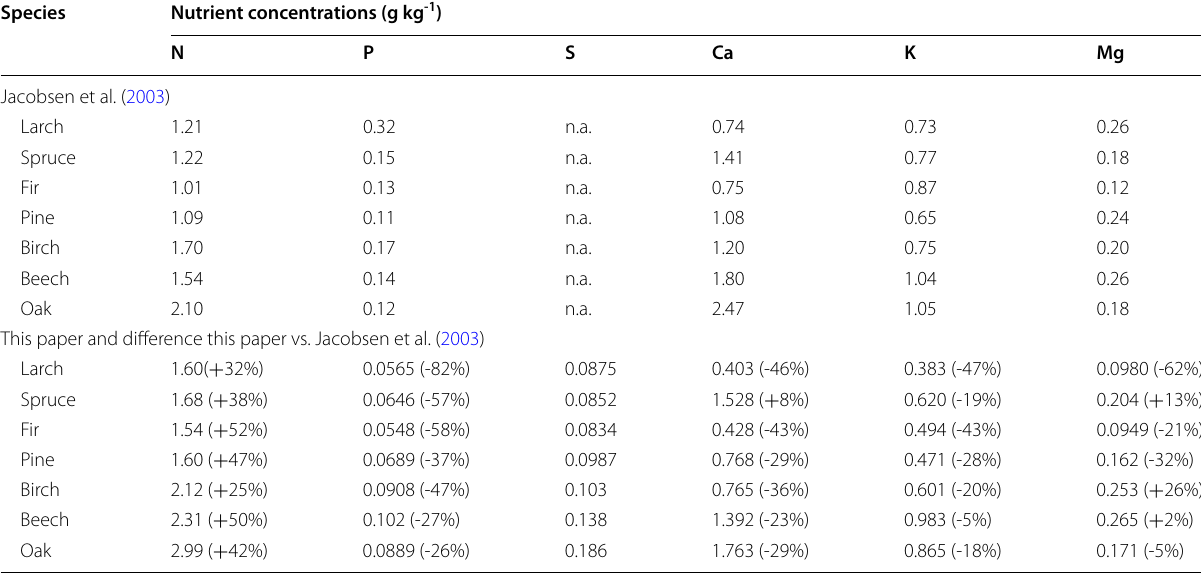
Table 2 Average concentrations (g kg -1 ) of major nutrients in stems, both including bark, according to Jacobsen et al. (2003) and this paper and the relative difference (%) between both datasets (% difference